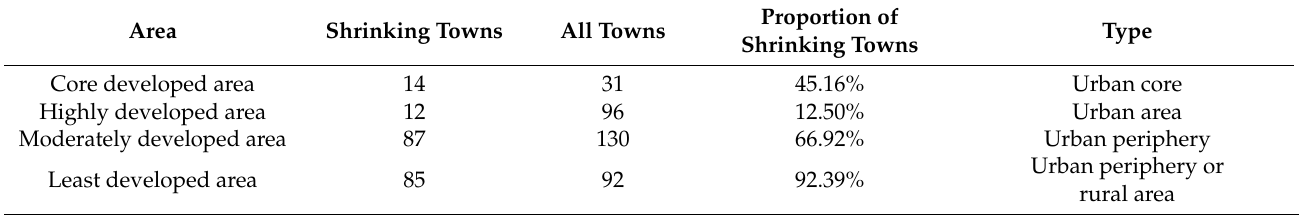
Table 10. Proportion of shrinking towns in each